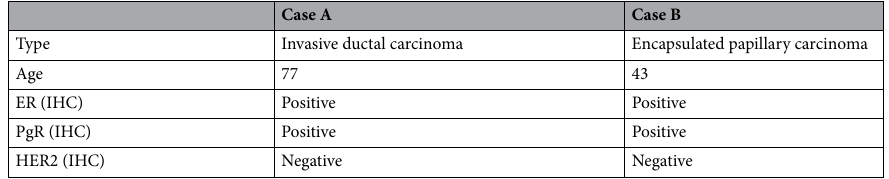
Table 2. Clinical information of two breast cancer cases. ER estrogen receptor, PgR progesterone receptor, HER2 human epidermal growth factor receptor 2, IHC